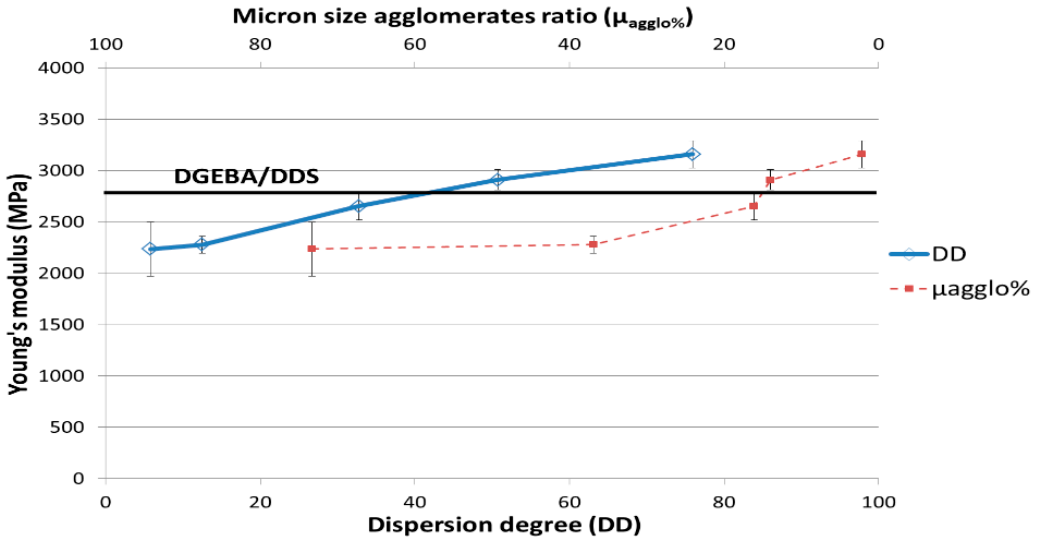
Figure 8. Gel time evolution as a function of the mixing conditions for the reactive system epoxy/amine/MWNT (0.7 wt %) at 150 °C.